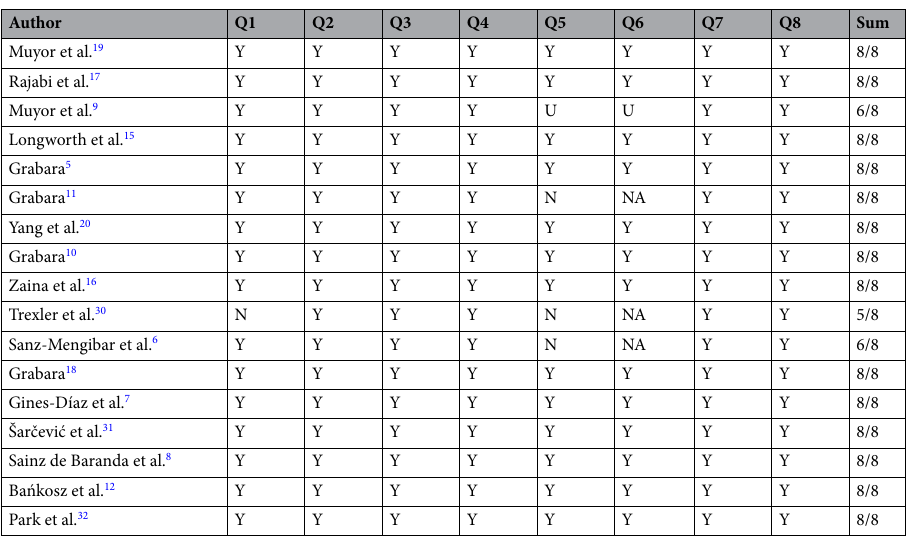
Table 1. The assessment of the methodological quality of the included studies (risk of bias) using the JBI method for analytical cross-sectional study. Q1 were the criteria for inclusion in the sample clearly defined, Q2 were the study subjects and the setting described in detail?, Q3 was the exposure measured in a valid and reliable way?, Q4 were objective, standard criteria used for measurement of the condition?, Q5 were confounding factors identified?, Q6 were strategies to deal with confounding factors stated?, Q7 were the outcomes measured in a valid and reliable way?, Q8 was appropriate statistical analysis used?, Y yes, N no, U unsure, NA not